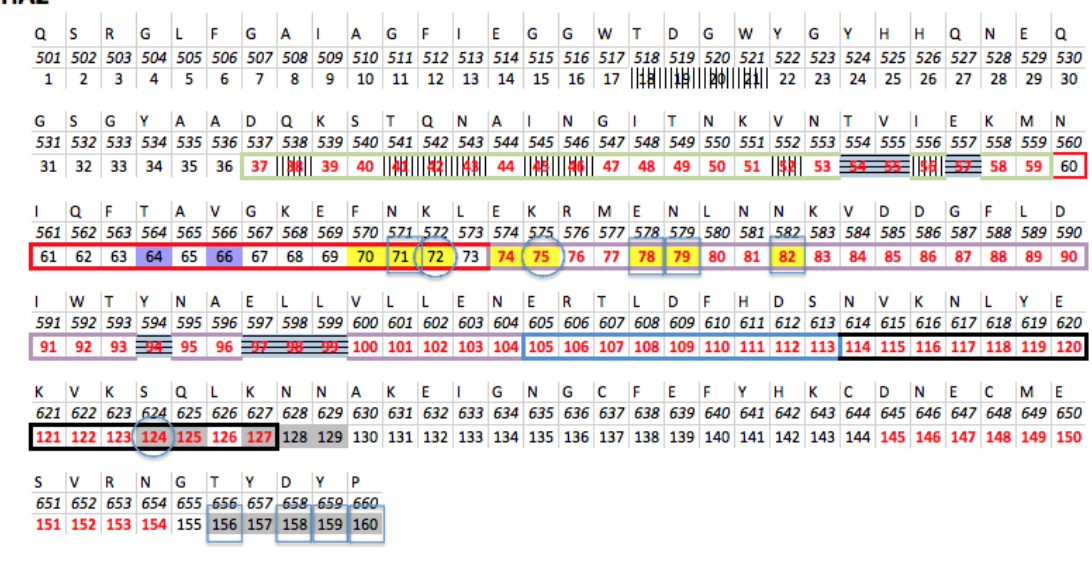
Figure 2. Hemagglutinin (HA) amino acid sequence, helix, loop and target positions. The HA1 and HA2 amino acid sequences of the 3D reference strain 1RU7.pdb are presented in this figure. The numbering of the positions used here is in italics and corresponds to that used in the protein databank (PDB) file of the three-dimensional reference sequence (1RU7.pdb). The second numbering links the PDB numbering with the ones of the H1N1 HA1 and HA2 positions used in the literature. The positions in red belong to a helical secondary structure. HA2 contains several helices: zone A is boxed in light green, loop B is boxed in red, zone C is boxed in violet, Kink is blue boxed, and zone D is boxed in black. The H1N1 targets: the third target (#83) described in this study is highlighted in yellow, the first one (#9) in light blue and the second one (#67) in grey. The target linked by the tert -butylhydroquinone (TBHQ) molecule in [24] is horizontally hatched. The target linked by the monoclonal antibody (Mab) C179 in [25] is vertically hatched. The invariant positions located in our target are surrounded by a square and the SL positions by a